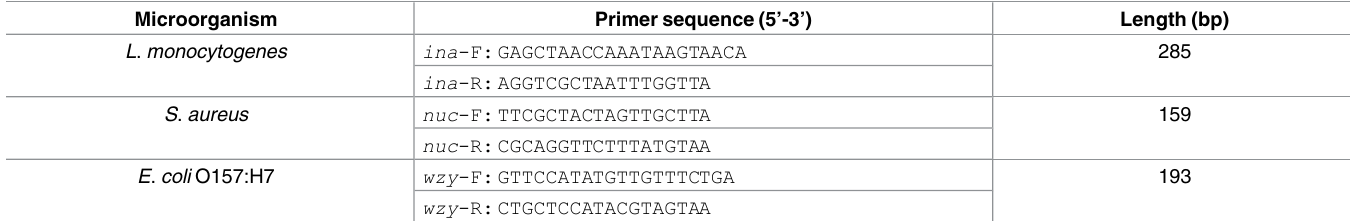
Table 2. Primer pairs designed for the multiplex PCR in this study.